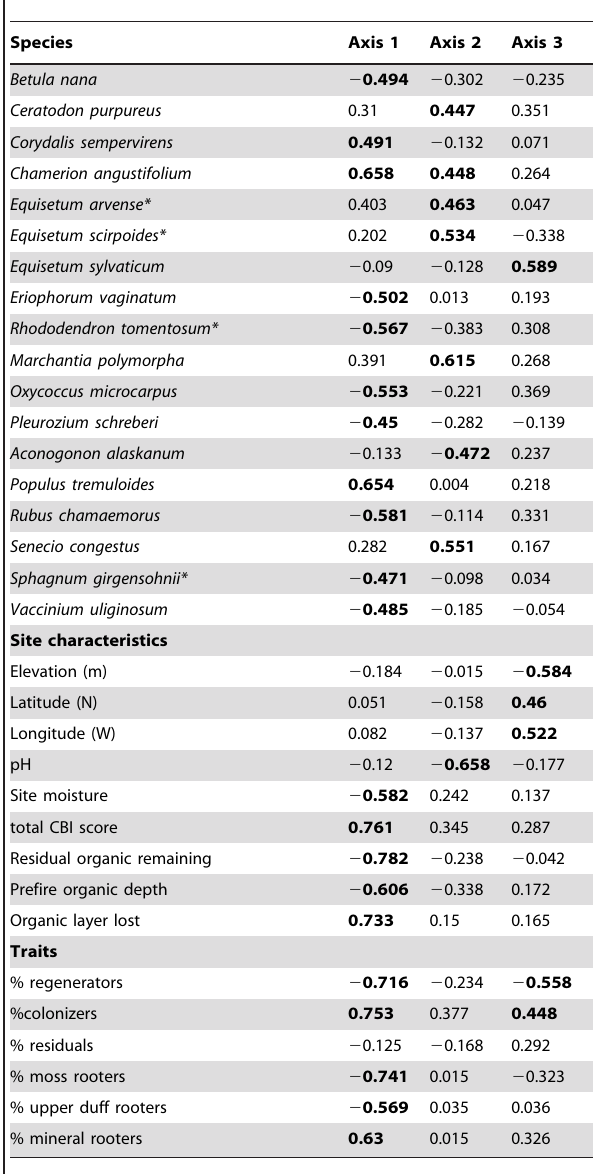
Table 1. The Kendall correlations of species, site characteristics, and plant traits for NMDS Axes 1, 2, and